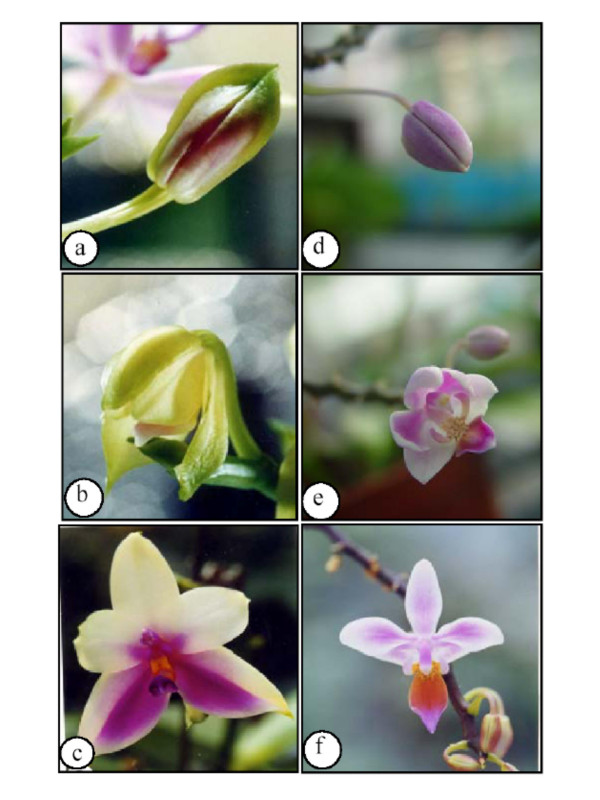
P. bellina (a-c) and P. equestris (d-f) flowers at different developmental stages. a, d: Day 3 pre-anthesis; b, e: Flowering day; c, f: Day 7 post-anthesis.